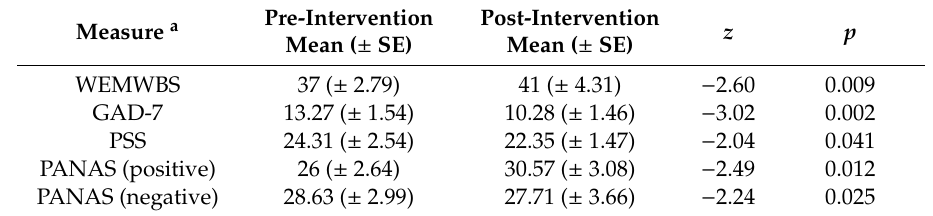
Table 2. Indicators of mental health Wilcoxon signed rank test, measured before and after the six-week wetland nature-based health intervention (n =